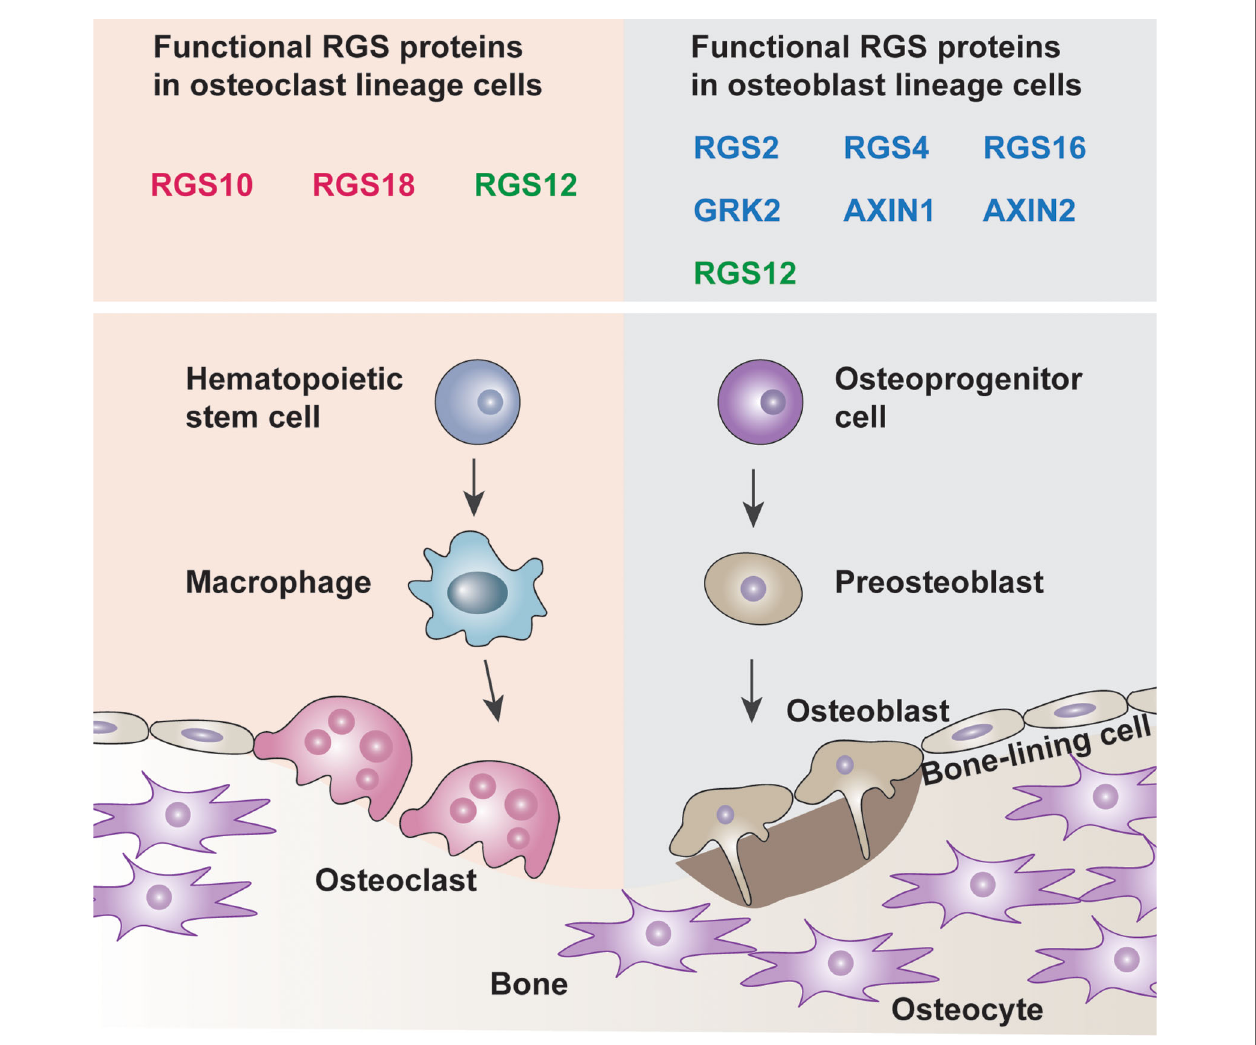
FIGURE 1 | Roles of RGS proteins in bone cells. Osteoblast lineage cells drive bone development whereas the osteoclast lineage cells promote bone remodeling. The balance between the osteoblasts and osteoclasts leads to bone homeostasis. The box indicated the known functional RGS proteins are expressed in the osteoclast lineage cells and osteoblast lineage cells (Red, osteoclast solely, Blue, osteoblast solely, Green, both osteoclast and